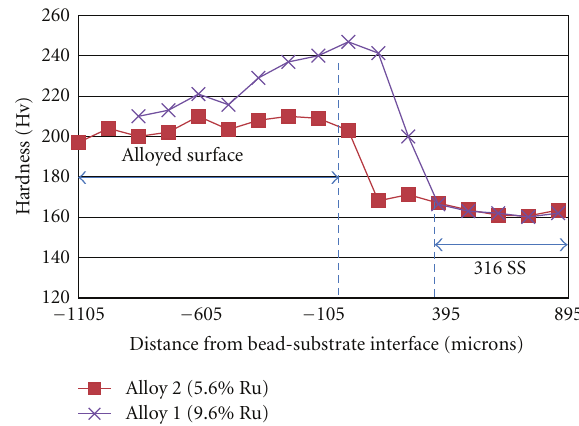
Figure 3: Variation of hardness with the distance from the bead/ substrate interface in an AISI 316 stainless steel surface alloyed with Ru. The hardness measurements showed an error of approximately 3%.